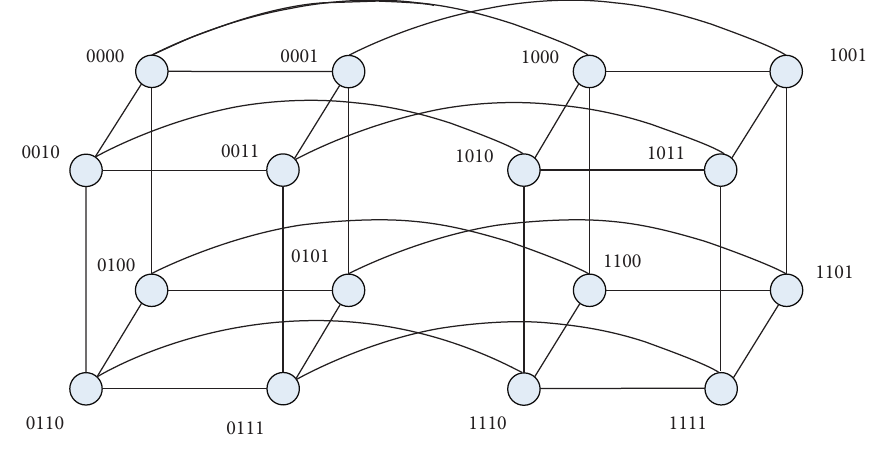
Figure 3: A 4-dimensional